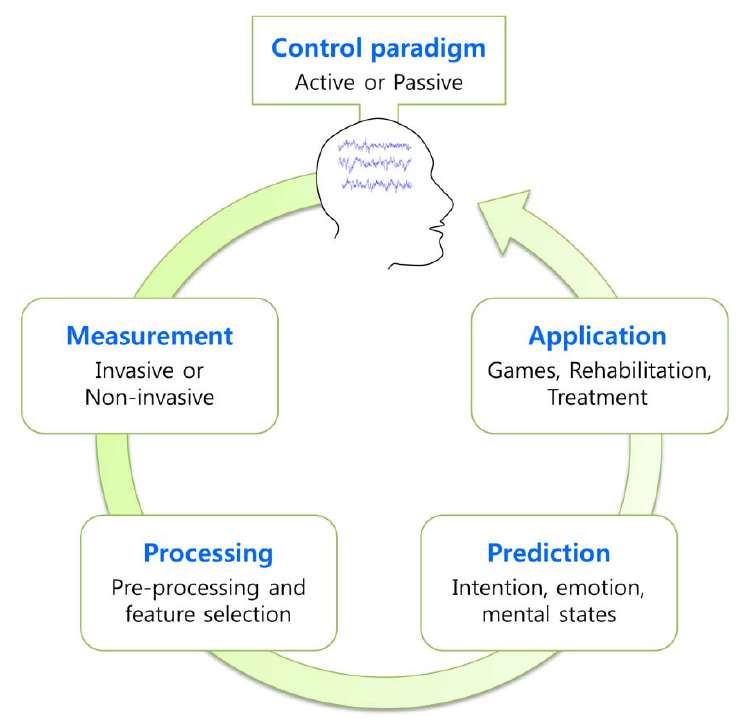
Figure 1. The Closed loop of